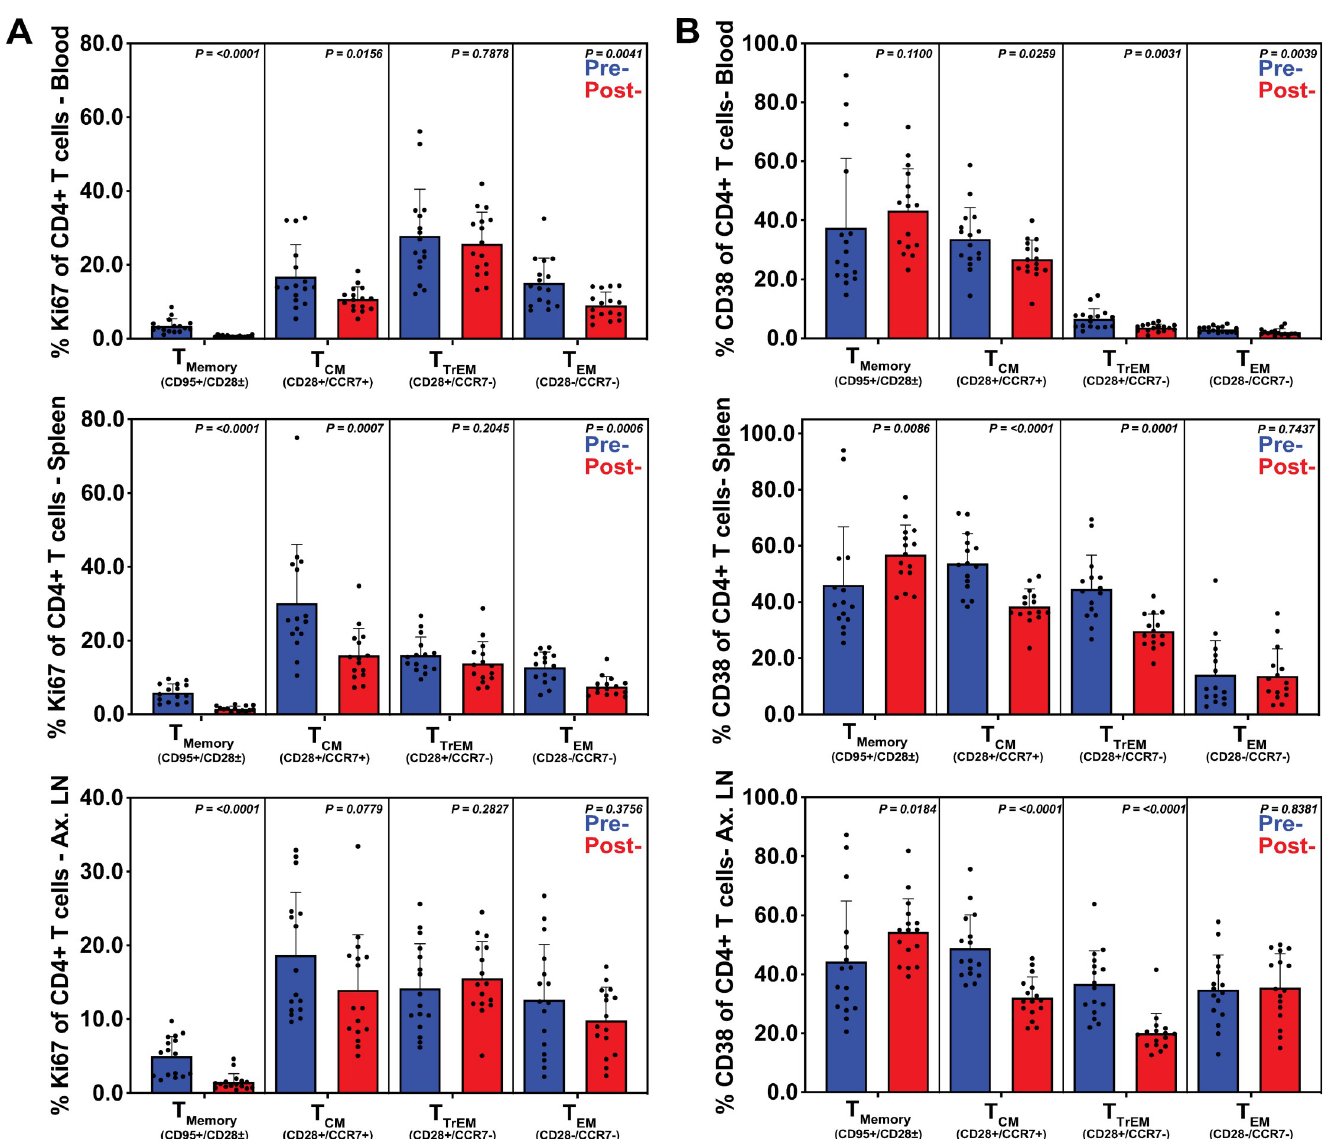
Fig 10. Elimination of EPs following short course multimodal therapy normalized systemic inflammation and immune activation in CD4+ T cells. Flow cytometric analysis was performed on CD4+ T cells derived from whole blood, spleen and axillary lymphoid (ALN) tissues, before and after multimodal treatment. Subsets were summed for overall responses with the figure showing the mean (+ SEM) of these overall responses for both pre- and post-treatment. Reduction in proliferation (Ki67) was observed in all tissues ( A ), especially in central and transitional memory subsets, as well as in whole blood and splenic effector memory populations. Decreased activation (CD38) was also observed in the central and transitional memory subsets in all three tissues ( B ) as well as in the effector memory subset in whole blood. Immune cell subsets were defined as described in Fig 5.